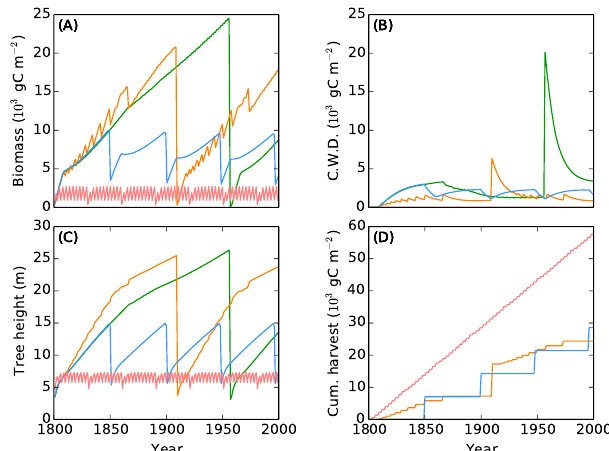
Figure 5. Impact of the different forest management strategies on an oak forest for unmanged (green), high stand (orange) and coppice (blue) compared to a Poplar short rotation coppicing (red) at 48 ◦ N, 2 ◦ E. The simulation was run without spin-up to better visualise car- bon build-up in the coarse woody debris (C.W.D.) pool.